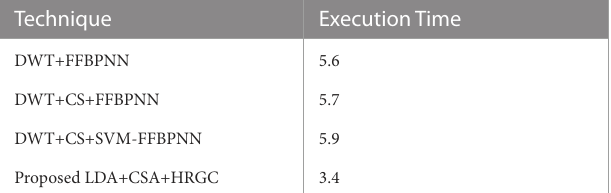
TABLE8 ComparativeanalysisofExecutiontime